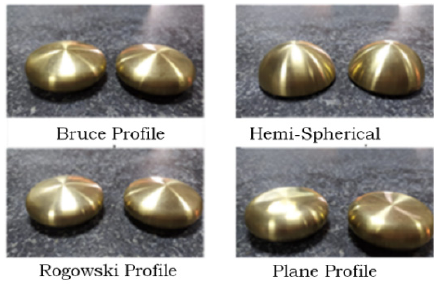
Figure 1. Photograph of various electrode pair configurations.